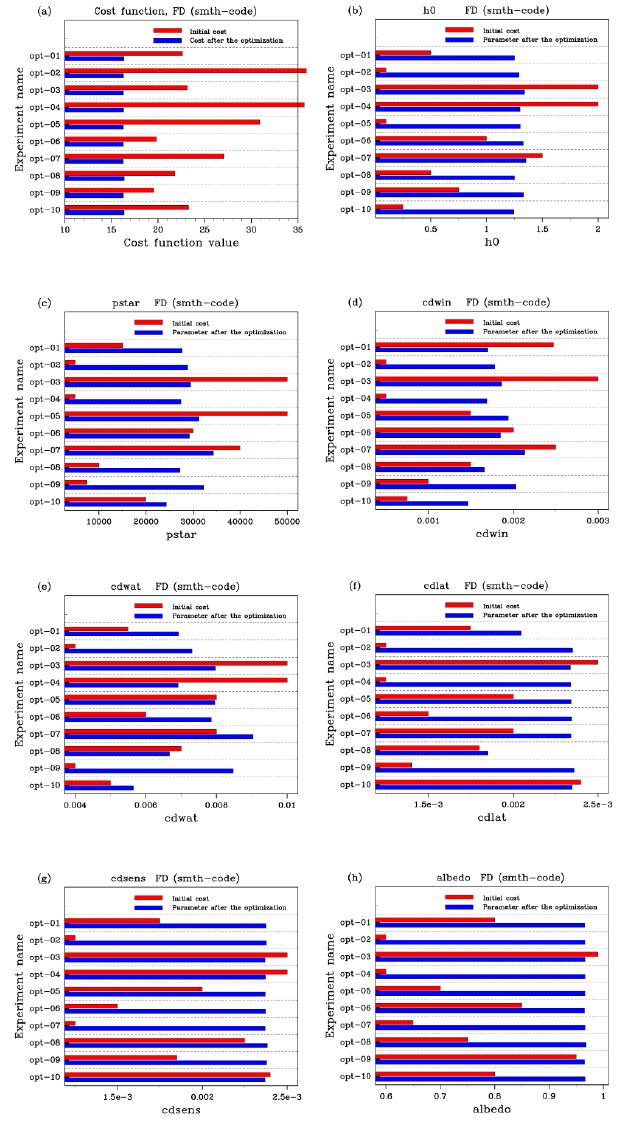
Fig. 11. The same as Fig. 9 but with the smth-code.